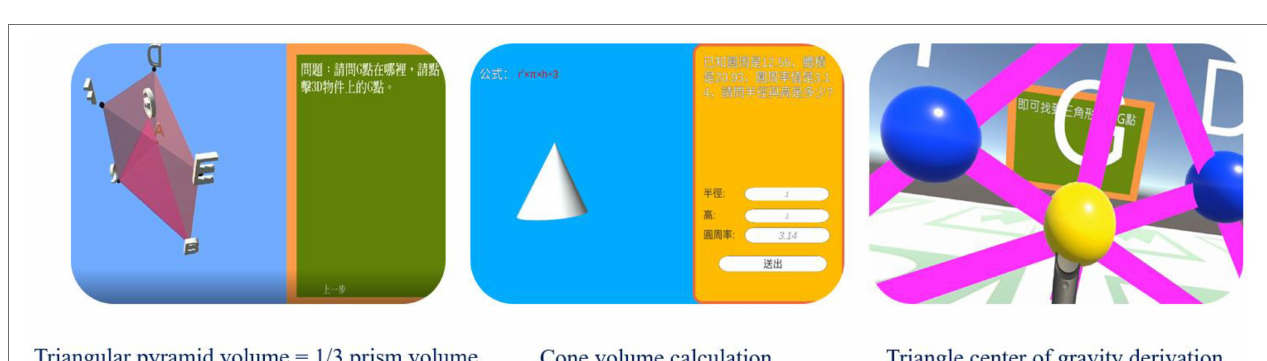
FIGURE 1 | The architecture of the virtual reality immersive learning mathematics geometry system.